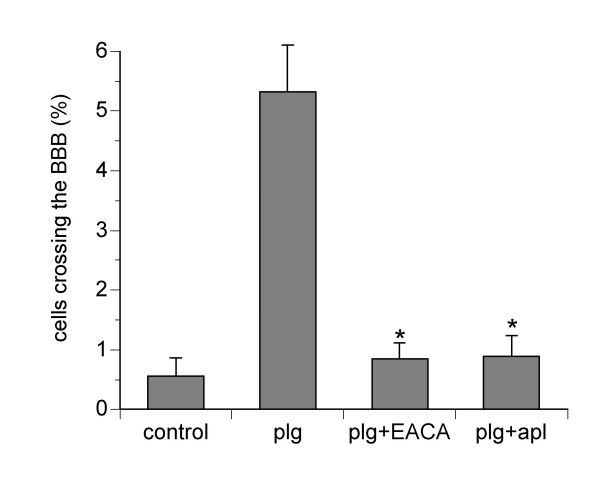
Cancer cell transversal of the in vitro blood-brain barrier model. 50,000 BMEC were plated on 6.5 mm ø transwells coated with collagen and 8.0 μm pore size in DMEM/F12/10%FCS/10%Nu serum. After 3 days the cells had grown to confluence and the medium was removed and replaced with DMEM/F12. After two more days 10,000 human SK-melanoma cells (SK-Mel) labeled with Cell-Tracker Orange™ were added. These co-cultures were further incubated in the absence of exogenous plasminogen (control), in the presence of 1 μg/ml plasminogen (plg) and in the presence of plasminogen and EACA (EACA). The results are the average of three experiments performed in duplicate. Error bars show standard deviation. *p < 0.01.